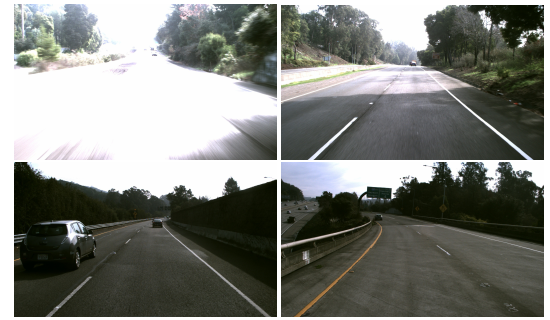
Figure 4. There are a number of challenges in the road boundary detection. The images can be underexposed or overexposed (up-left); the shadow can lead to incorrect lane detection since the brightness of image abruptly changes (up-right); the road boundaries are occluded by other vehicles (down-left); The road can be curvy and fitting a line to the curvy road may be cumbersome